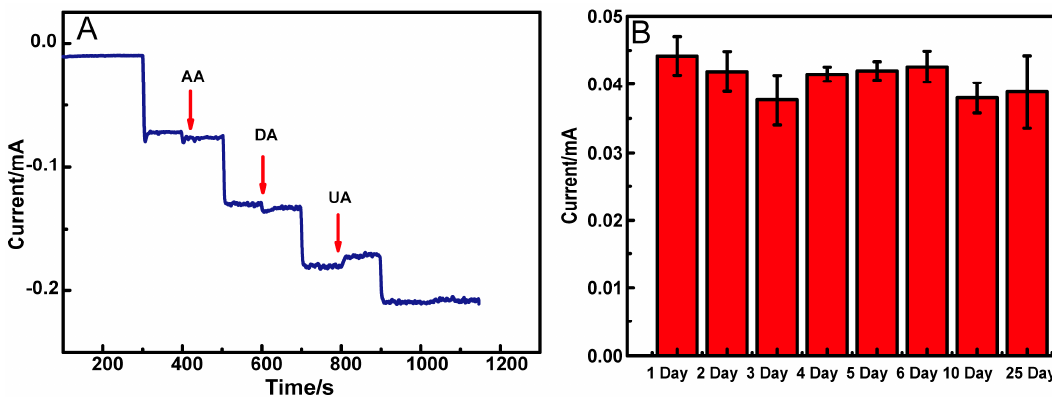
Figure 8. ( A ) Amperometric responses of CuO/PCL@PPy/ITO to successive additions of 1.0 mM glucose and 0.01 mM ascorbic acid (AA), dopamine (DA), and uric acid (UA) in 0.01 M NaOH at − 0.7 V; ( B ) The current response of the CuO/PCL@PPy/ITO electrode to 0.1 mM glucose within 25 days.